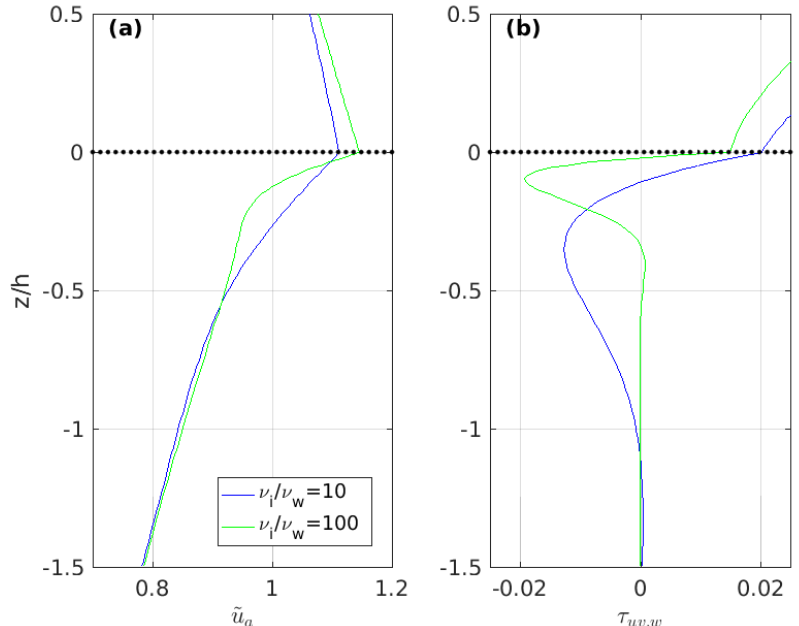
Figure 14. Theoretical solutions from the linear theory of waves in two layers of fluid with a viscous ice layer overlaying less viscous water [34]: ( a ) vertical profiles of velocity amplitude ˆ u a , ( b ) the corresponding wave-induced Reynolds stress τ uv , w , where u and v are the linear fluid velocities of the wave motion. Note that, in contrast to Figures 12 and 13, the minimum depth reached by the ice—water interface is designated z = 0 on these panels (dotted line). The velocities are normalized by | v ( z = 0) | (i.e., the vertical velocity magnitude at z = 0). The normalization does not change the shape of the profiles. As in [34], relative ice viscosity and thickness values are prescribed by Reynolds (cid:112) gh / ν i = 5, with two values of ice/water viscosity ratio, ν i / ν w . The dimensionless number R e = h frequency (cid:101) ω =